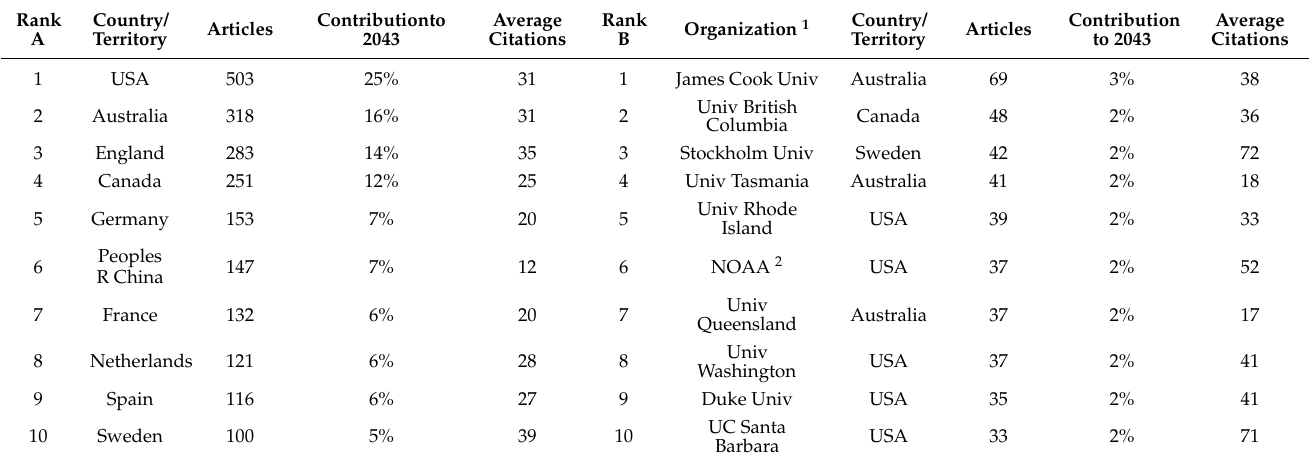
Table 2. Main global references to territorial and organizational contribution on coastal